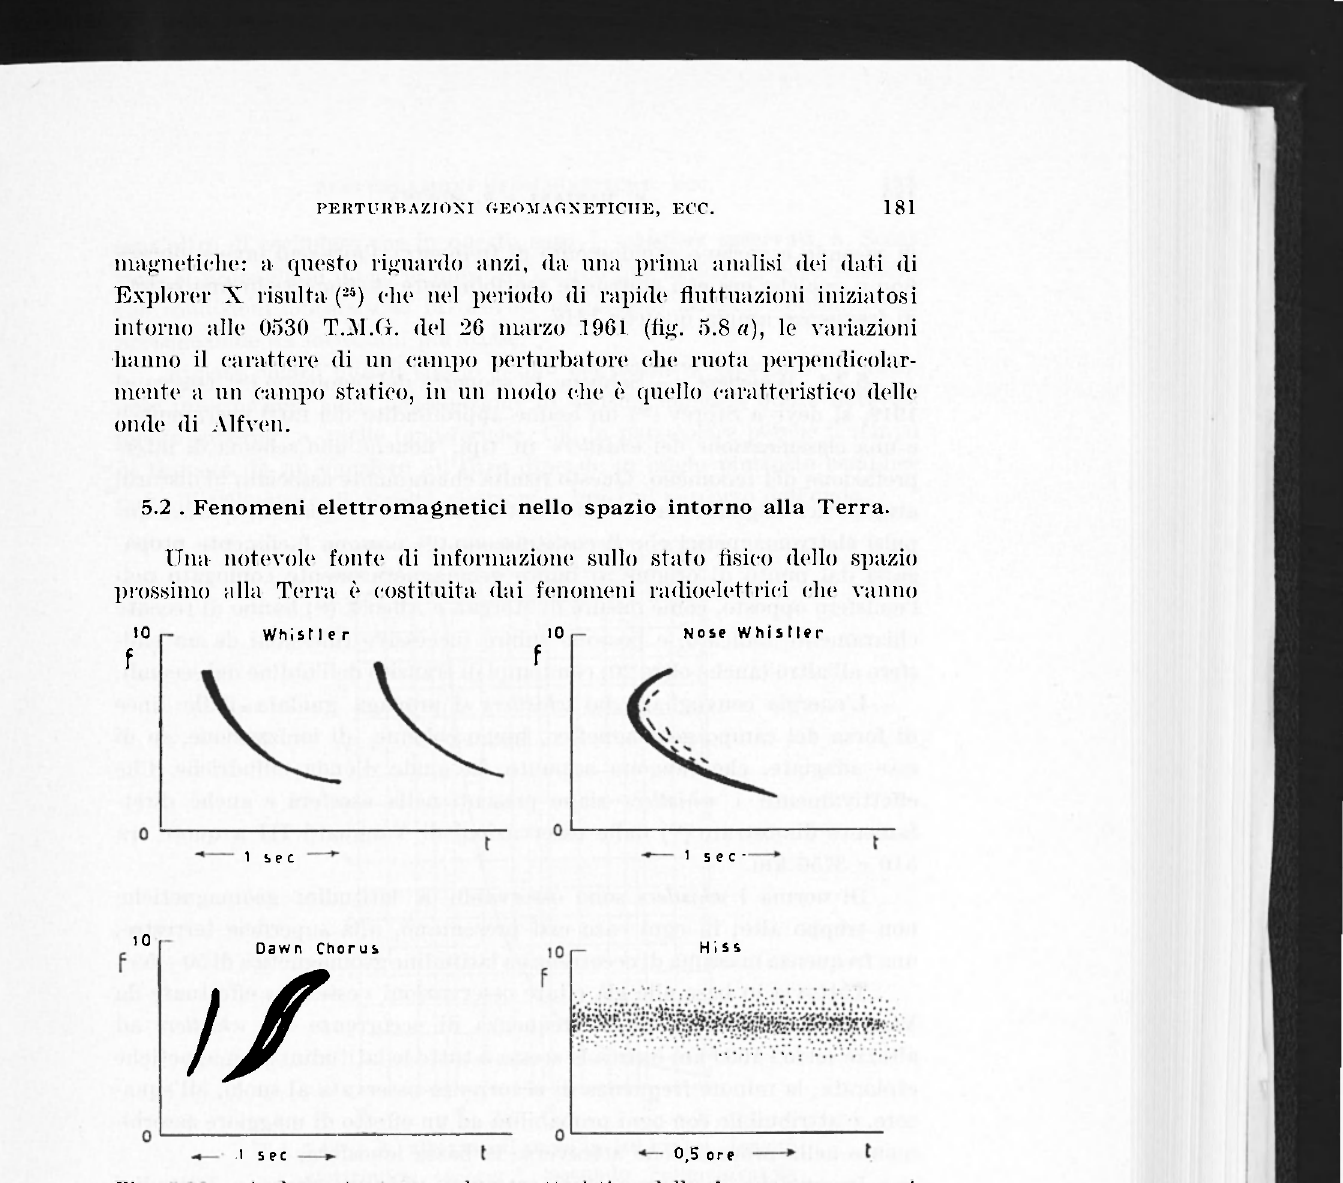
Fig. 5.10 - Andamento temporale caratteristico della frequenza per vari tipi di emissione elettromagnetica di frequenza acustica: /, fre- quenza in kHz; sono indicate le durate